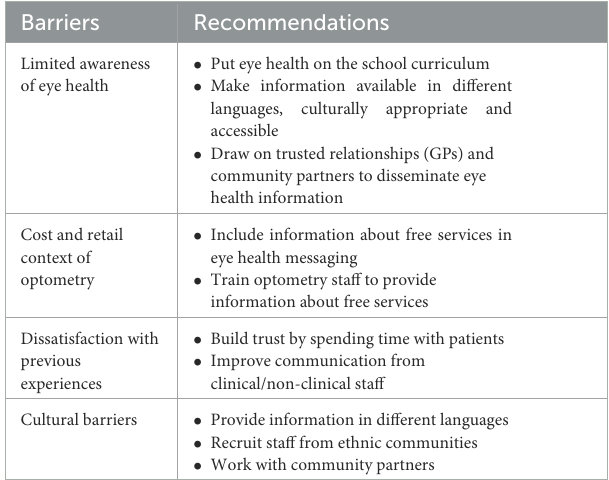
TABLE 1 Common barriers and recommendations to increase uptake of primary eyecare